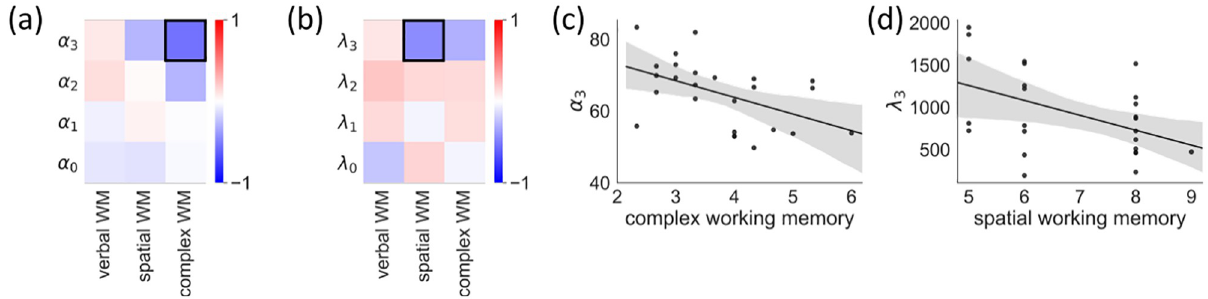
Fig 5. Correlation between the fitted HCRP parameters and working memory. (a)(b) Pearson correlation matrices of the working memory test scores and the strength parameters α and decay parameters λ of the HCRP model, respectively. Correlations that met the significance criterion of p < .05 are marked with black boxes. (c)(d) Scatter plots of the correlations that that met the significance criterion of p < .05. Bands represent the 95%